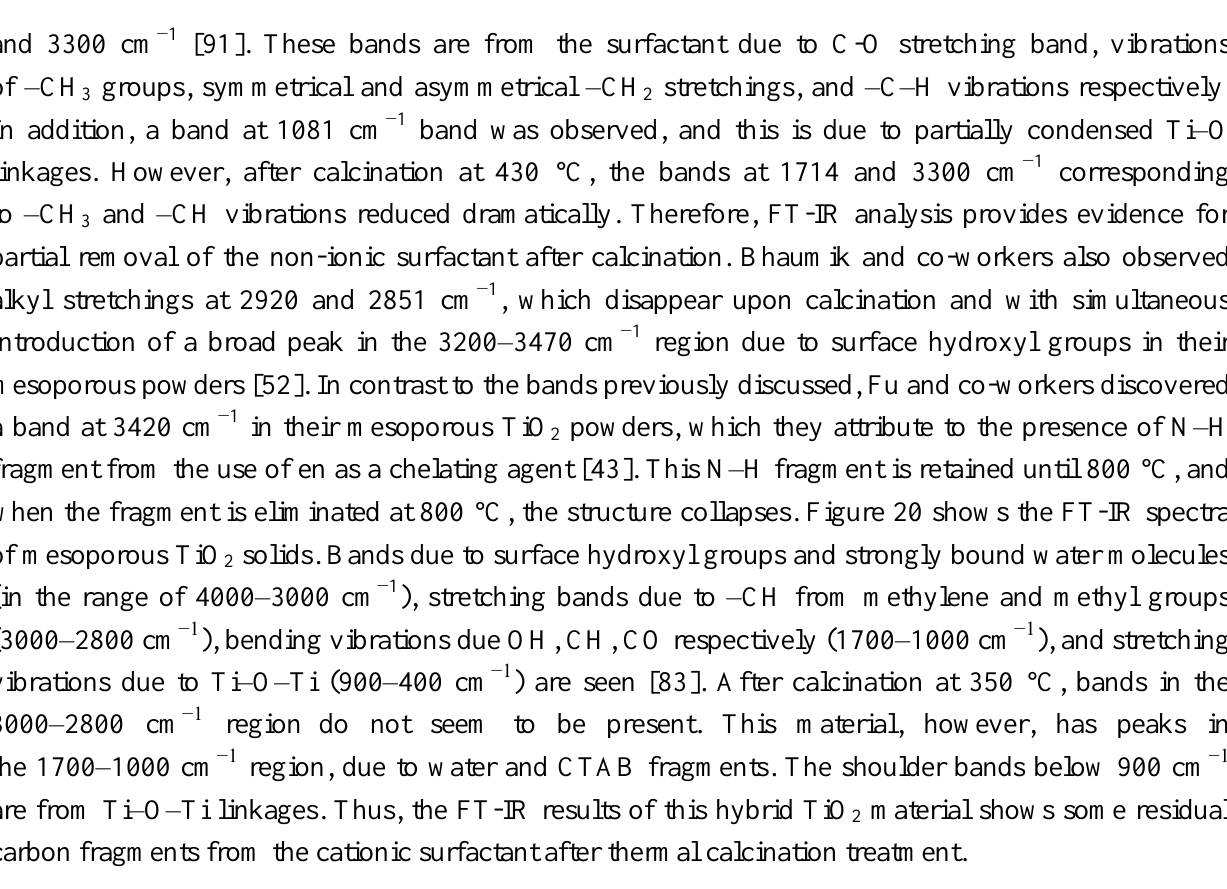
Figure 20. FT-IR spectra of mesoporous TiO